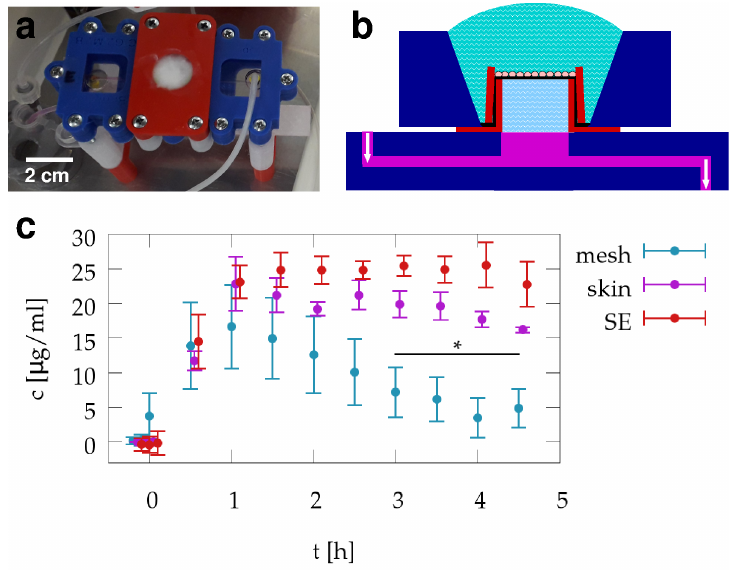
Figure 3. Transdermal transport measurements using skin equivalents and human skin. A photo ( a ) and schematic drawing ( b ) shows the sample holder device fitted into a microfluidic Franz chamber inside an incubator box. The cap of the chamber immobilized the sample holder device and held the caffeine-containing cream in close contact with the skin equivalent. Medium was transfused through the microfluidic chamber, and fractions of the medium leaving the chamber were collected every 30 min. ( c ) Caffeine concentration in the collected fractions was measured by spectrophotometry and is shown as a function of time. Caffeine exposition was started at t = 0. Red, magenta and teal colored symbols represent the average caffeine concentration obtained from the skin equivalent, human skin and cell-free samples, respectively. Error bars represent SEM, from n = 3 independent experiments. The difference between concentration readings from the marked mesh-only and SE samples is significant ( p = 1.2 · 10 − 7 , n = 12 in each